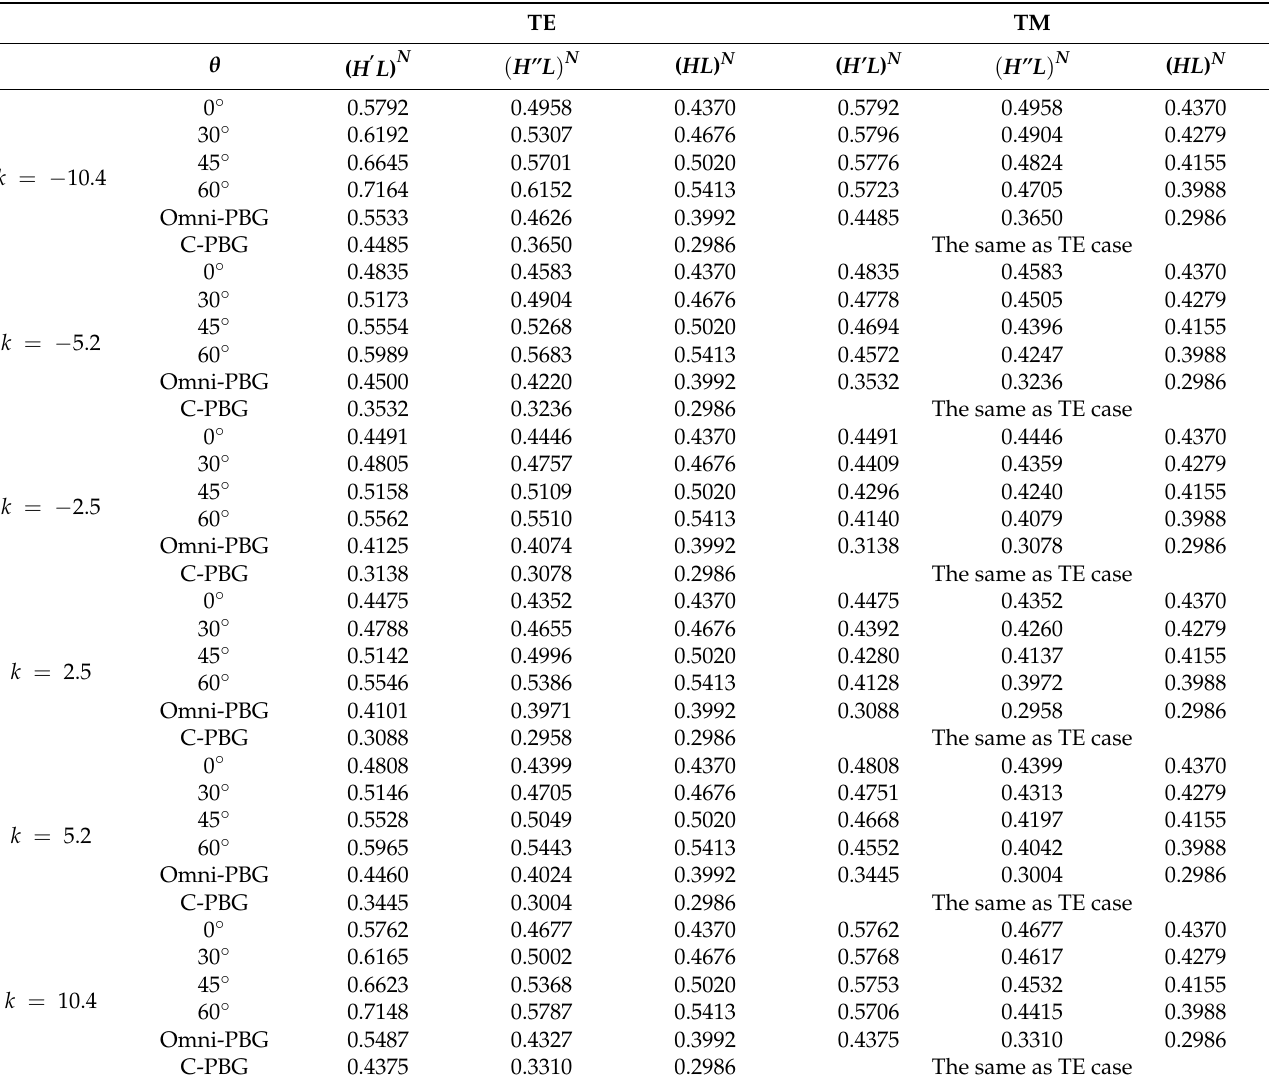
Table 1. PBG, omni-PBG, C-PBG (in unit ω / ω 0 ) for Model 1 ( H (cid:48) L ) N , Model 2 ( H (cid:48)(cid:48) L ) N and